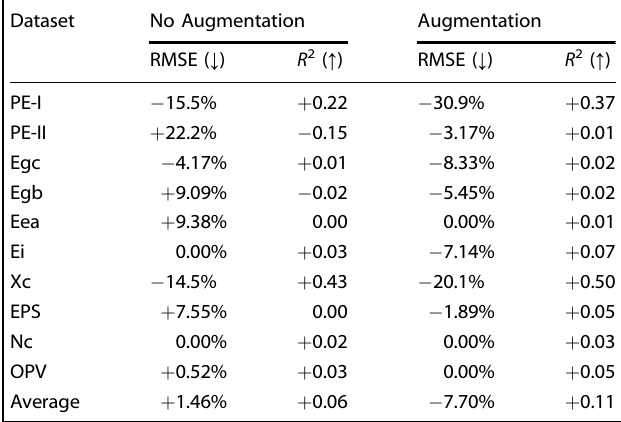
Table 8. Improvement of performance of TransPolymer pretrained without and with data augmentation in fi netuning compared with best baselines in terms of decrease of test RMSE (in percentage) and increase of test R 2 (in absolute